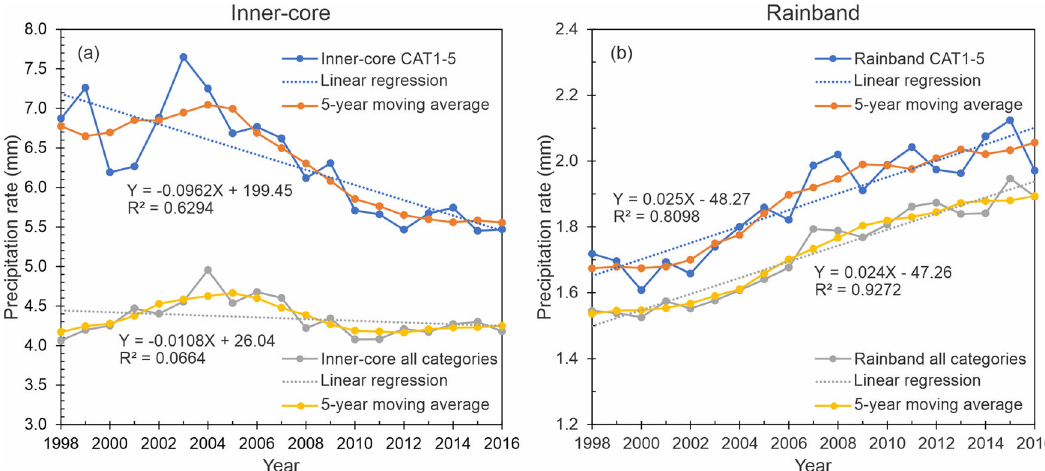
Fig. 3 Time series and the linear regression fi t of averaged rain for different TC regions. a mean TC inner-core rain, and b mean TC rainband rain in all global TC-prone basins. Plots are showing averages for all intensity categories and for hurricanes from CAT1 to CAT5. The linear fi tting function and square of the correlation are indicated. The 5-year moving average is also shown.